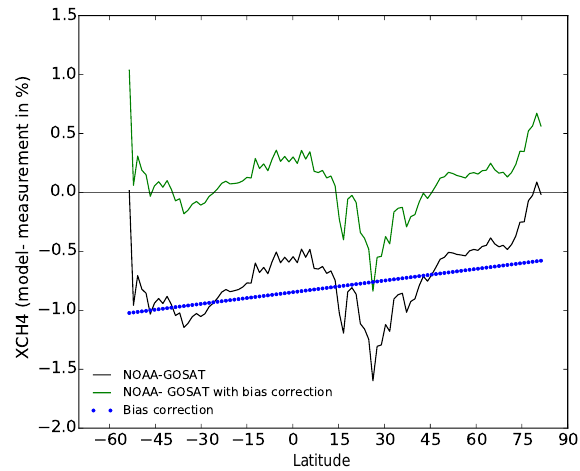
Figure A2. NOAA-based bias correction applied to XCH 4 in the PR-CT inversion.